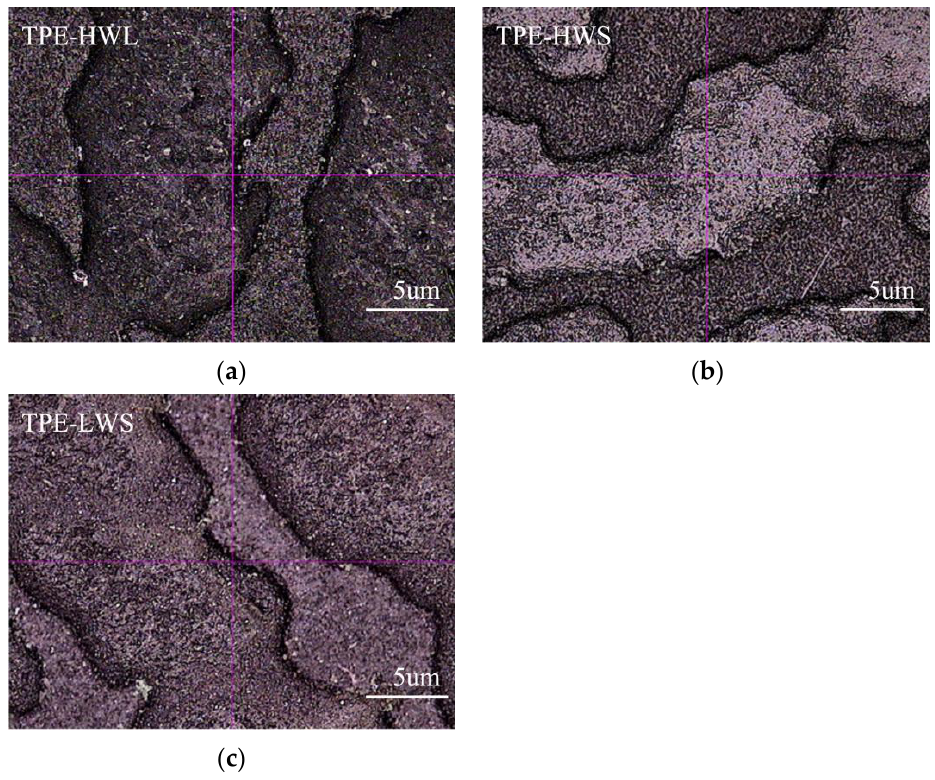
Figure 9. 40 times magnified photos of samples prepared by SEBS with various molecular structures after Taber-abrasion test. ( a ) TPE-HWL; ( b ) TPE-HWS; ( c ) TPE-LWS.